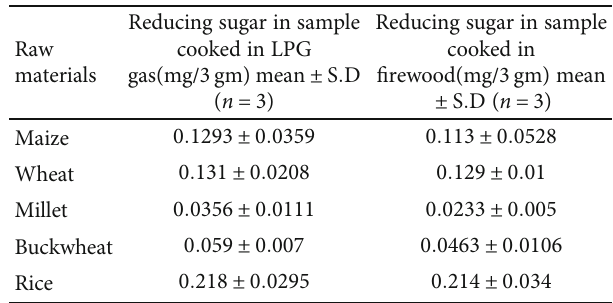
Table 3: Reducing sugar content in sample cooked in LPG gas and fi rewood.